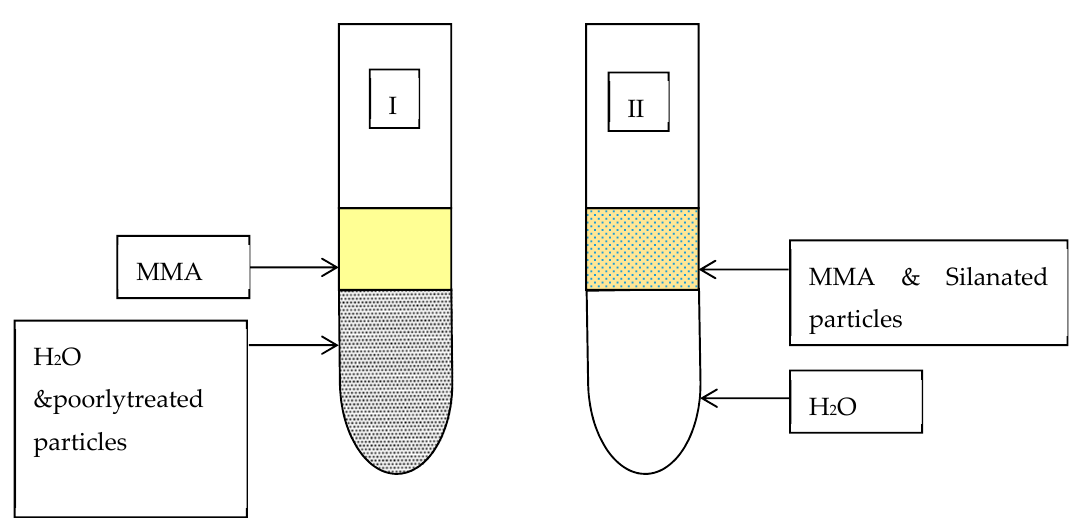
Figure 4. Qualitative method to assess the compatibility of silanated particles with MMA.